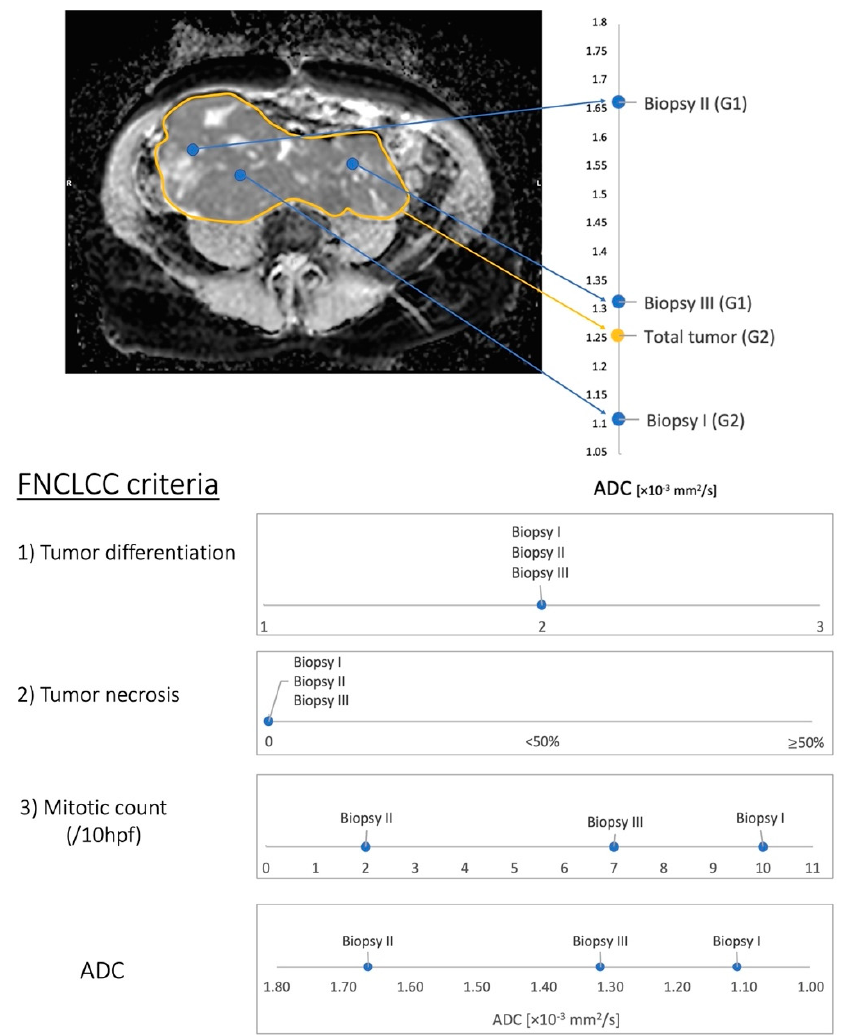
Figure 4. Distribution of the ADC of the entire tumor and the three collected biopsies. The